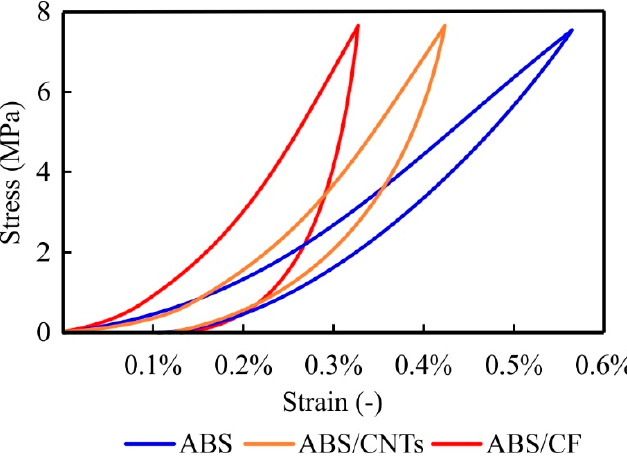
Figure 6. Hysteresis loops of ABS, ABS/CNT and ABS/CF FFF printed specimens.